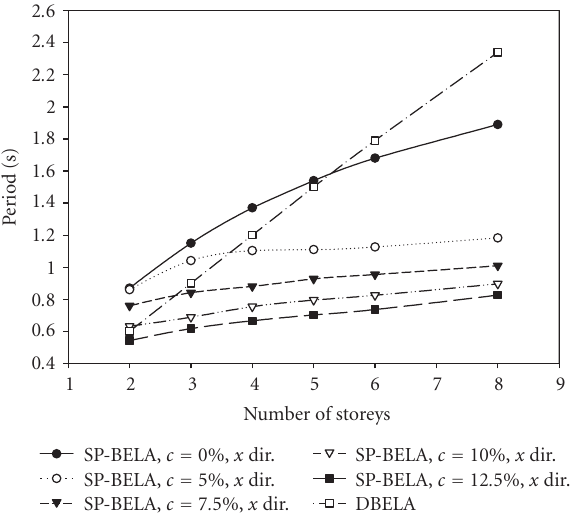
Figure 10: Mean yield period of vibration versus number of storeys for new buildings (DBELA) compared with the seismically designed buildings (SP-BELA) in the x